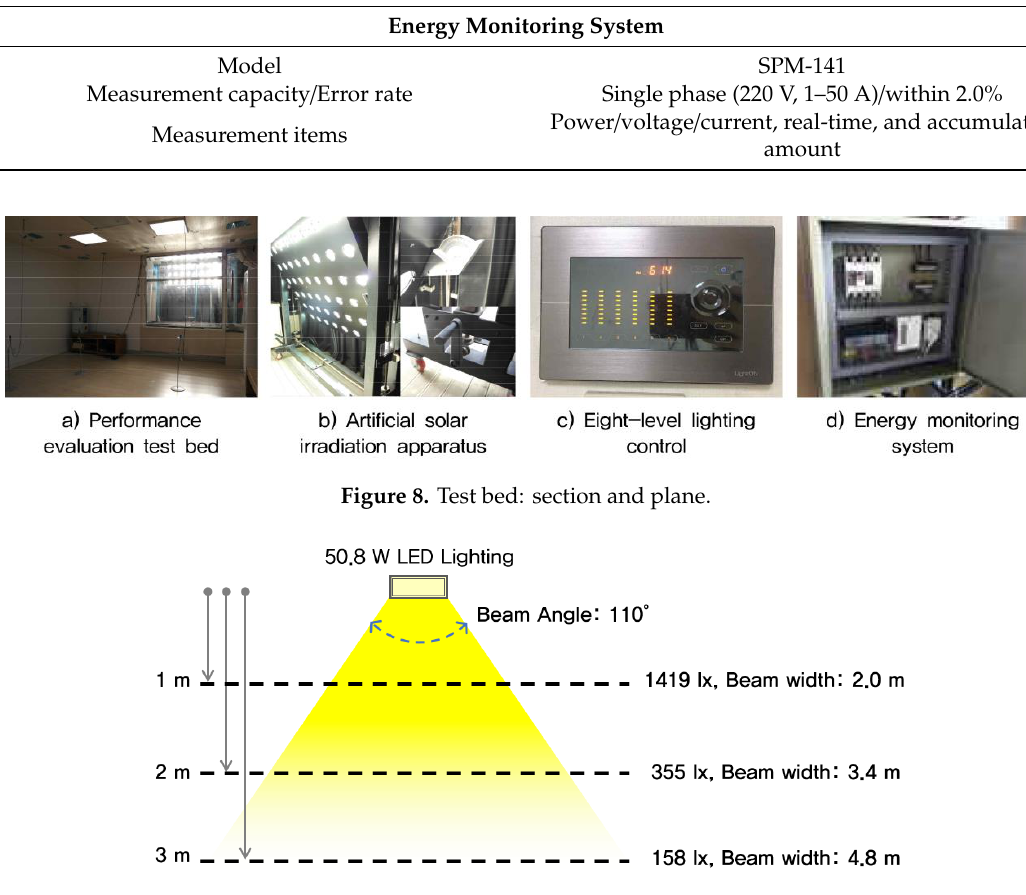
Figure 9. Light distribution and conical illuminance of lighting. Table 5. Solar altitude and external illuminance by time period for summer, mid-season, and winter. Season